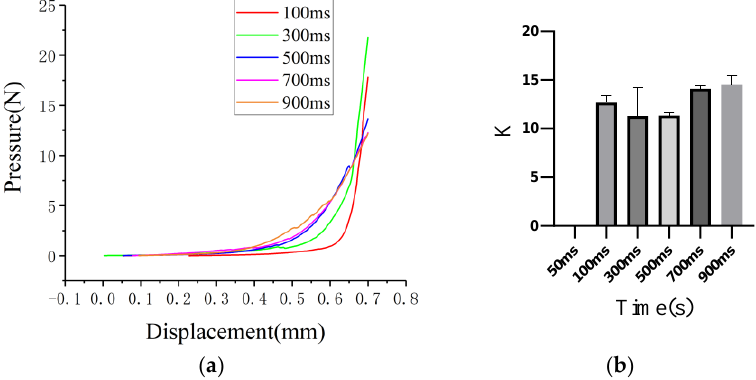
Figure 6. The mechanical properties of MNs with different exposure time: ( a ) the pressure-displacement curves of MNs with different exposure time; ( b ) the K of MNs with different exposure time. K was defined